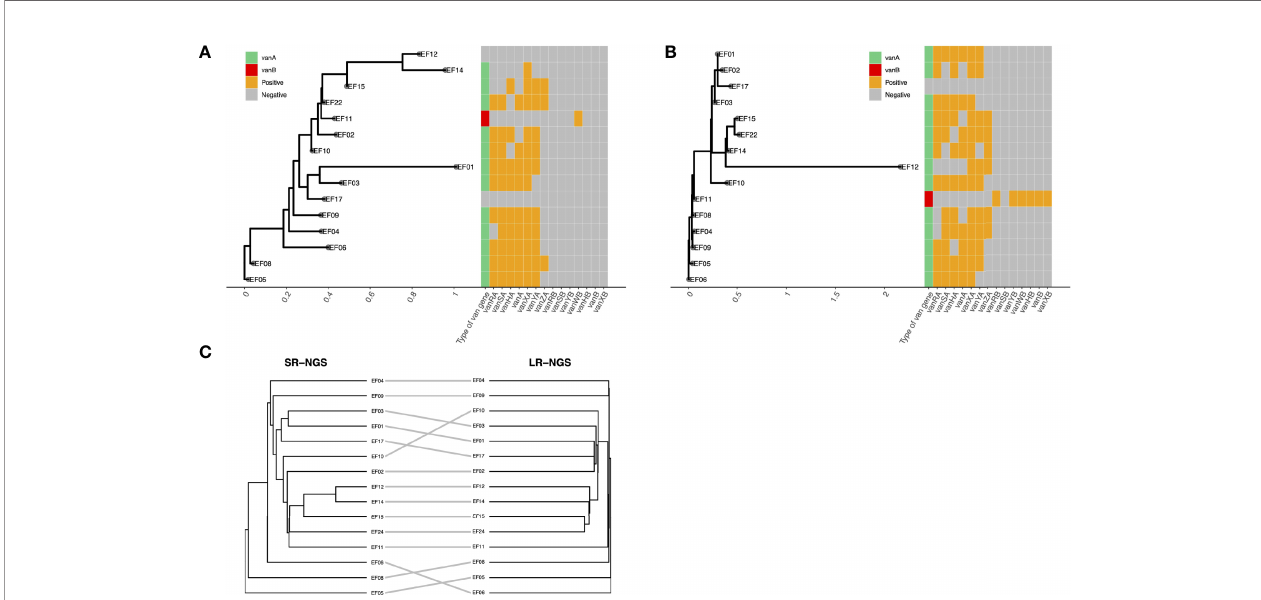
FIGURE 3 | Comparison of the single-nucleotide polymorphism-based strain typing results of short-read next-generation sequencing (SR-NGS) and long-read next- generation sequencing (LR-NGS) for vancomycin-resistant Enterococcus faecium . (A) and (B) depict the maximum-likelihood phylogenies constructed using SR- and LR-NGS, respectively. The heatmaps on the right show the van gene clusters. (C) shows a tanglegram of the two phylogenetic